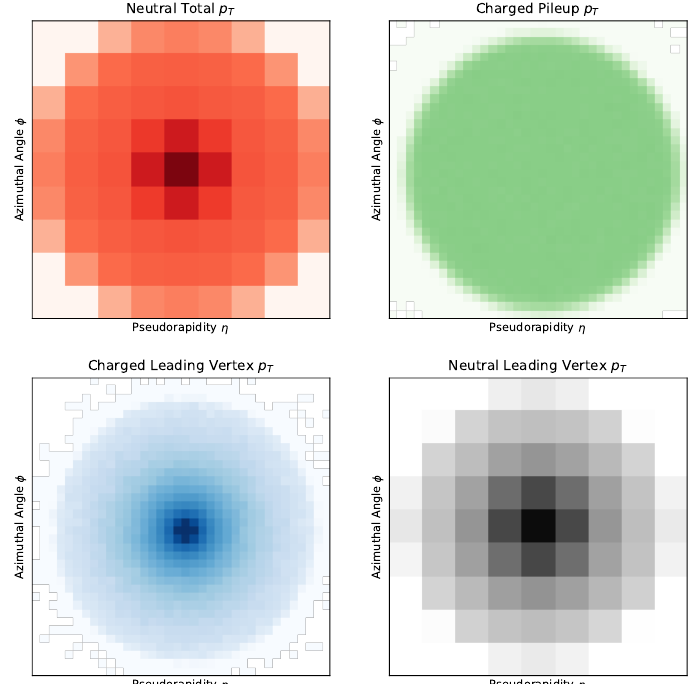
Figure 2 . The average leading-jet images for a 500 GeV scalar decaying to light-quark jets with h NPU i = 140 pileup, separated by all neutral particles (top left), charged pileup particles (top right), charged leading vertex particles (bottom left), and neutral leading vertex particles (bottom right). Di(cid:11)erent pixelizations are used for charged and neutral images to re(cid:13)ect the di(cid:11)erences